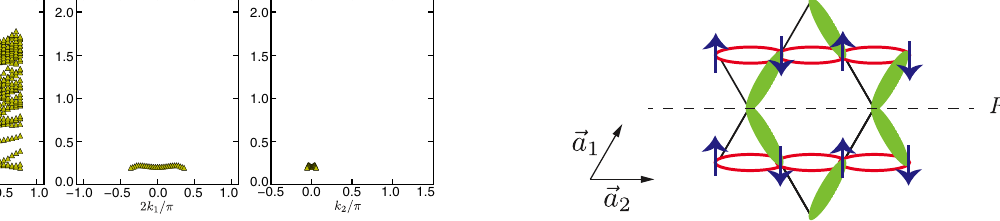
FIG. 18. The kagome spin liquid on the YC8-2 cylinder is unstable to an ordered state when θ ¼ π . The ordered state spontaneously breaks the spin-flip symmetry P x ¼ (hence, the time-reversal symmetry) by forming a staggered Ising magnetization ( h S z i i ≈ (cid:2) 0 . 03 ) as represented by arrows. It breaks lattice symmetry, with bond correlations h − 0 . 26 (green solid bonds), − 0 . 22 (red hollow bonds), and − 0 . 17 (black thin